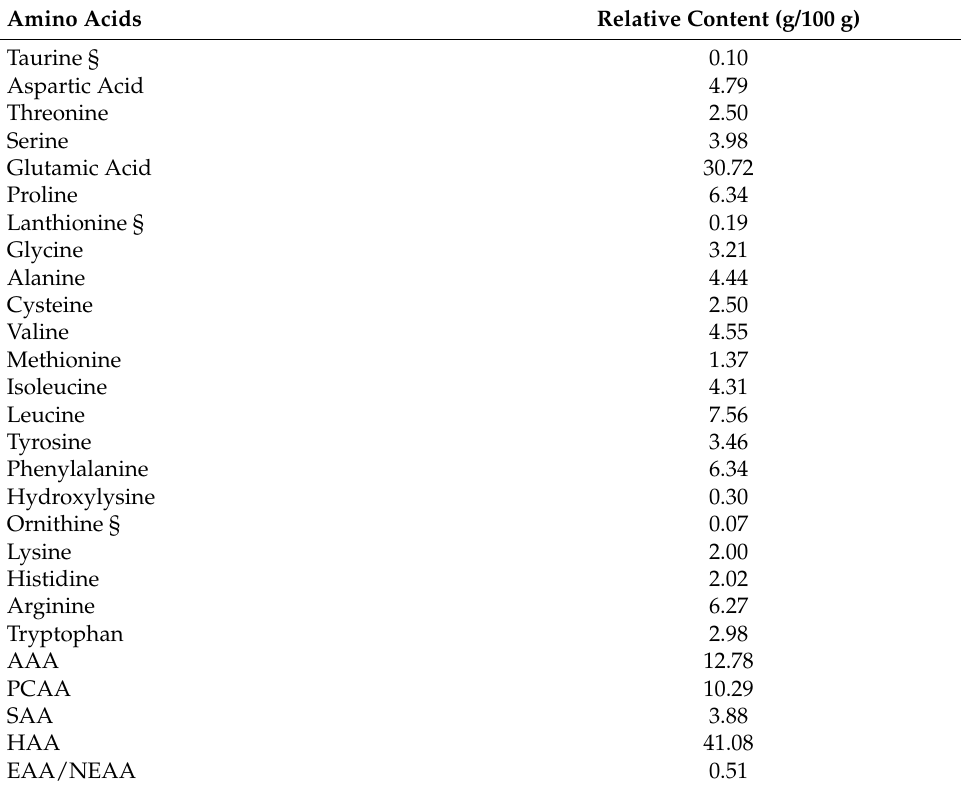
Table 1. Total amino acid composition of canary seed peptide obtained from simulated gastrointestinal